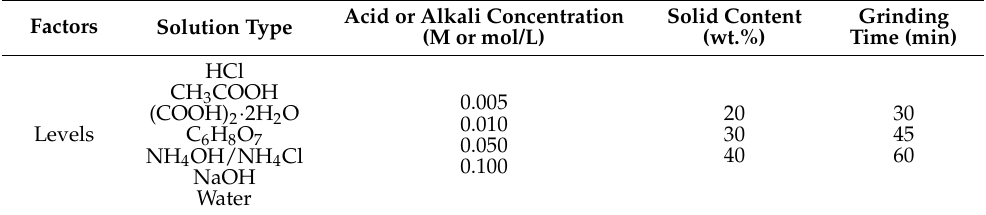
Table 1. The different experimental factors and levels during the experiment. Factors Solution